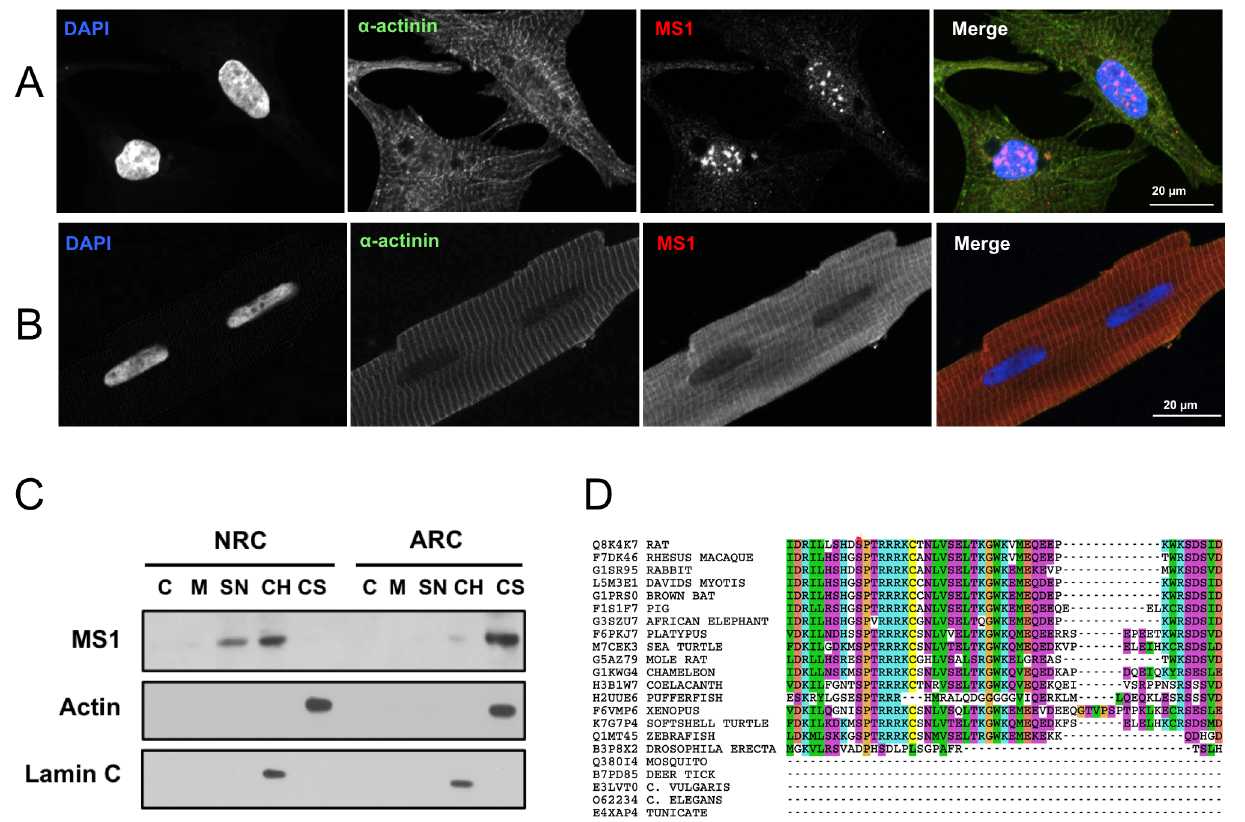
Fig 5. Subcellular localisation of Ms1. A: Immunofluorescent detection of endogenous Ms1 in NRCs. Staining is (left-to-right) DAPI (nuclei, blue), α -actinin (green) and Ms1 (red). B: as A but in ARCs. C: western blot detection of Ms1 in subcellular fractions isolated from ARC and NRC cultures. C = cytoplasm, M = membrane, SN = soluble nuclear, CH = chromatin bound, CS = cytoskeleton. D: Sequence alignment of Ms1 in the region of the nuclear localisation signal (NLS). Phosphorylation sites identified experimentally are indicated by a star [41]. Colours and the subset of sequences are identical to those in Fig 2B. Note that Ms1 from lower organisms lack this region of the